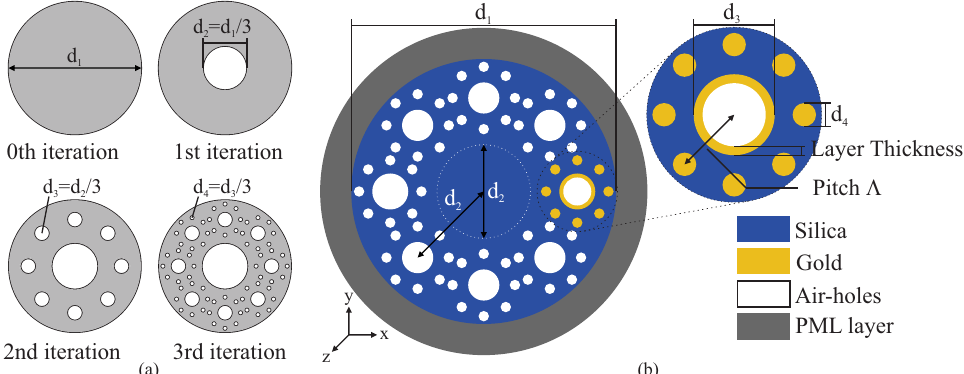
Figure 1. ( a ) Pictorial representation of the generation of a Sierpinski-like circular cross-section. ( b ) The Sierpinski-like cross-section used in the surface plasmon resonance (SPR)-photonic crystal fiber (PCF). The inset is used to show the geometry of the plasmonic fractal subset and to identify different materials considered in the simulations. The center circle, indicated by a dashed circle, corresponds to the dielectric fiber